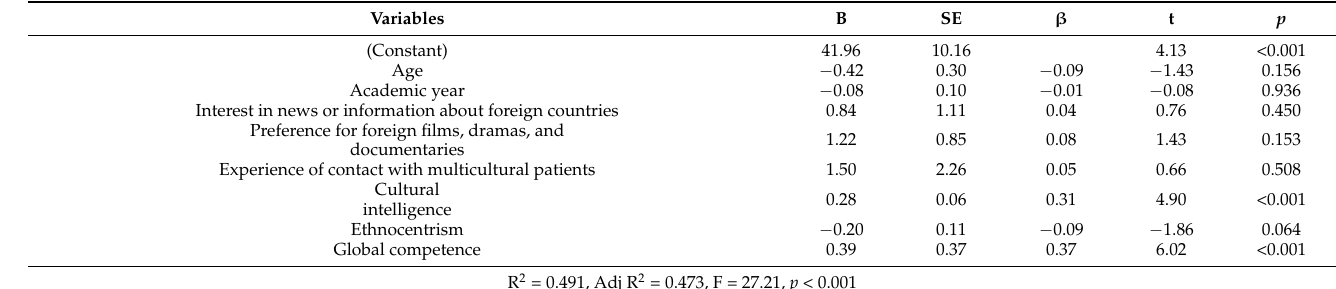
Table 4. Influencing factors of nursing student’s cultural competence (N =